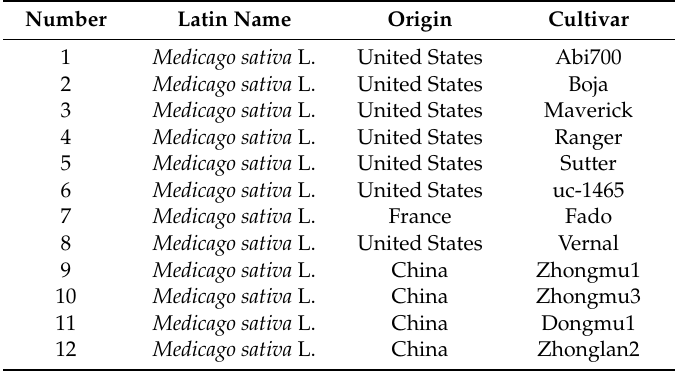
Table 1. Seeds information of Medicago sativa